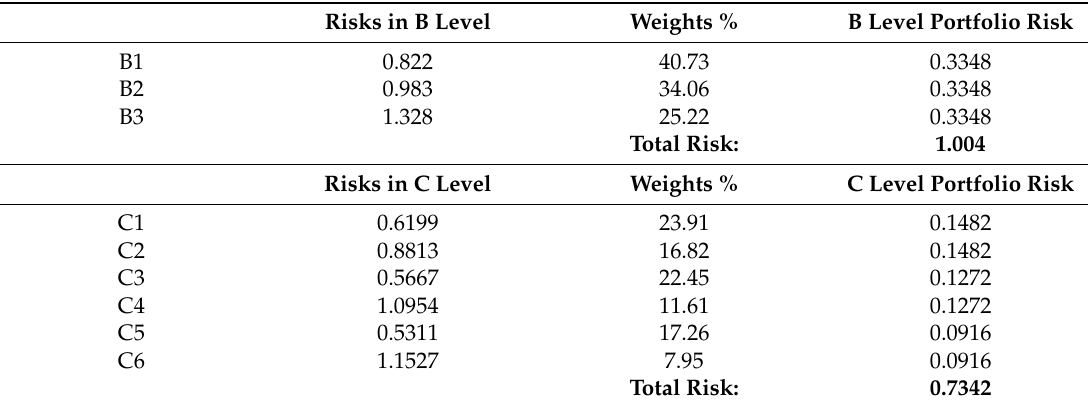
Table 9. The optimal weight sets for the B, C, and D